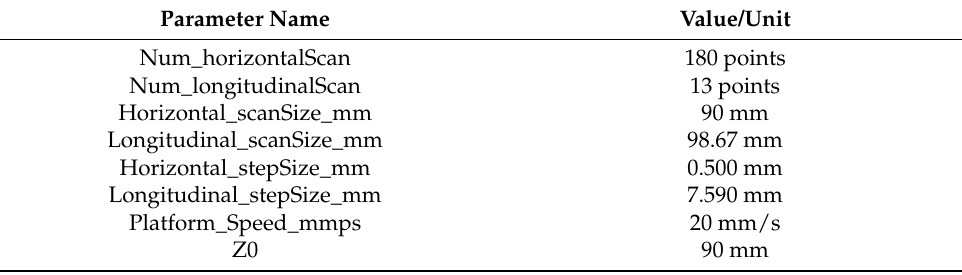
Table 2. X , Y axis mechanical control parameters and target distance.